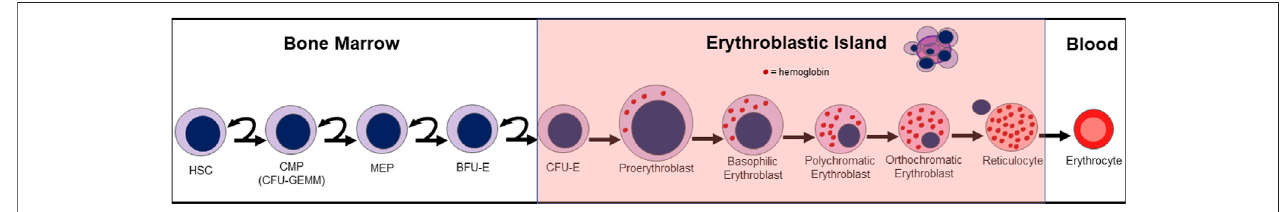
FIGURE 1 | Normal erythropoiesis. HSC (hematopoietic stem cell); CMP (common myeloid progenitor); CFU-GEMM (multipotential colony-forming unit); MEP (megakaryocyte erythroid progenitor); BFU-E (blast-forming unit-erythroid); CFU-E (colony-forming